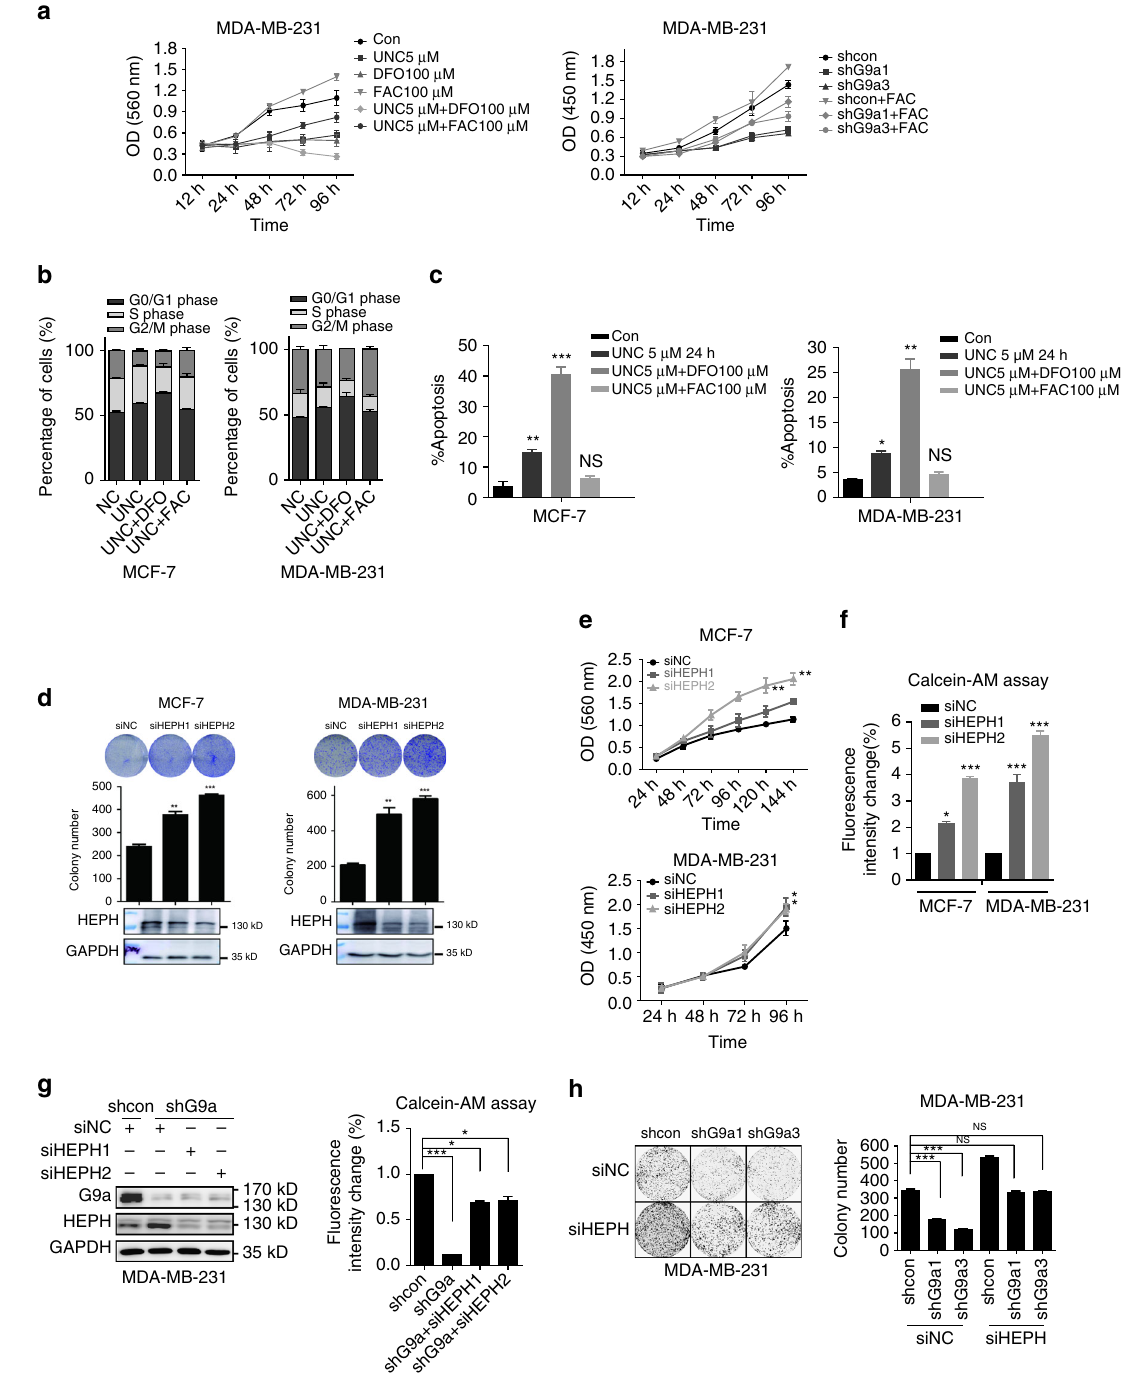
Fig. 4 G9a regulates breast cancer growth through cellular iron content. a Growth curves of MDA-MB-231 cells with or without G9a inhibitor treatment and G9a knockdown cell lines cultured in standard media or media supplemented with 100 µ M DFO or 100 µ M ferric ammonium citrate (FAC). Cell cycle arrest b and apoptosis c caused by G9a inhibitor could be enhanced or reduced under iron depletion or overload. Data represents the mean of three independent experiments. Silencing HEPH promoted MCF-7 and MDA-MB-231 colony formation d and cell growth e . f The cellular labile iron pool (LIP) in HEPH knockdown cells were tested. g Western blotting analysis of G9a and HEPH expression levels ( left ) and cellular LIP content of MDA-MB-231 cells after G9a and/or HEPH knockdown ( right ). h Colony formation ability was restored when HEPH was depleted by siRNA in G9a knockdown cells. The results are presented as means ± SD from three independent experiments. Two-tailed unpaired Student ’ s T -test was performed. * P < 0.05, ** P < 0.01 and *** P < 0.001, NS not signi fi